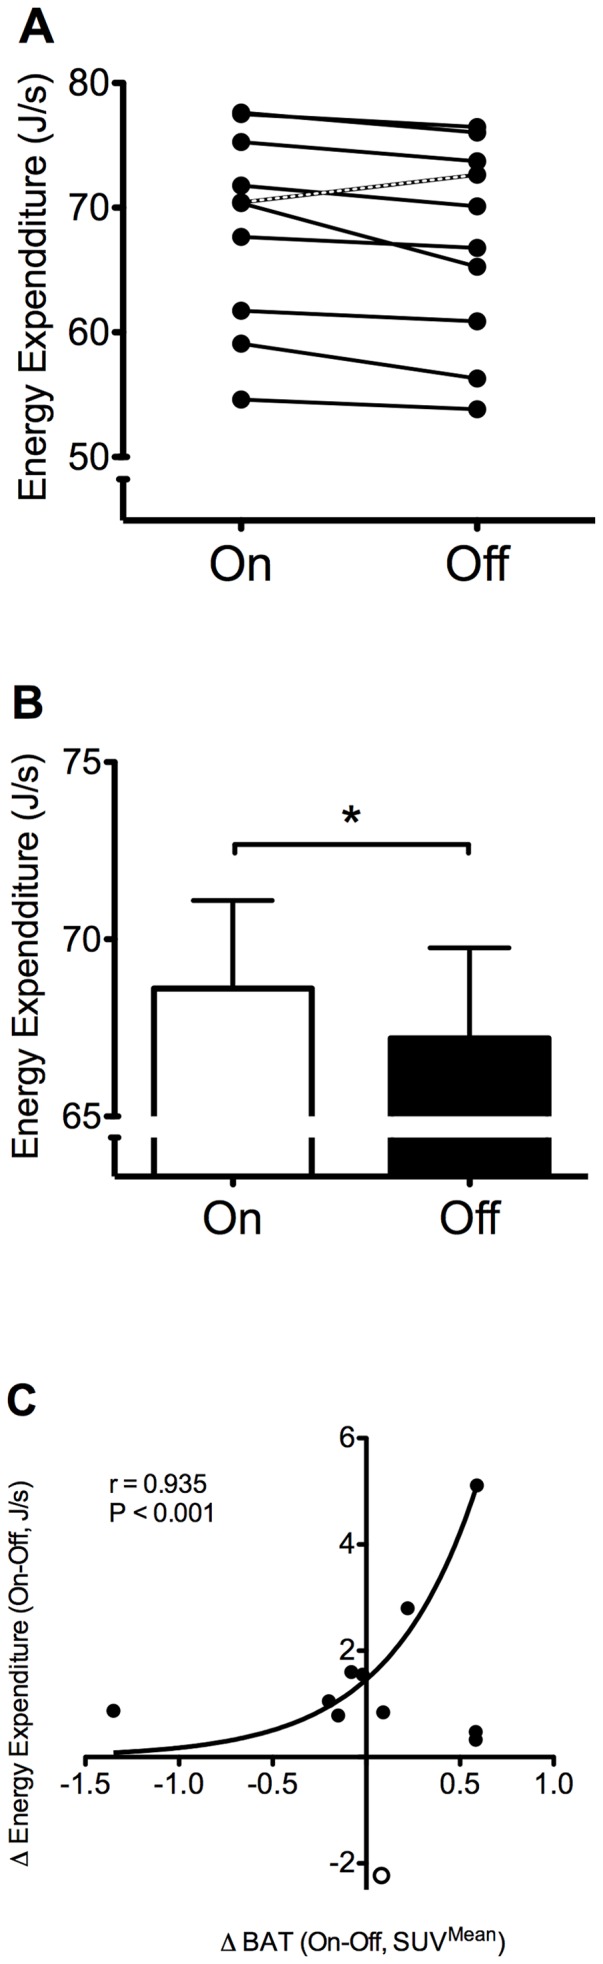
Basal metabolic rate (BMR) during active and inactive VNS in relation to BAT activity.
A. Individual responses upon VNS intervention. Notice all but one (marked line) subjects decreased energy expenditure upon deactivation of the VNS (subject that increased energy expenditure also described in Results section). B. Mean group BMR upon VNS intervention. C. The change in energy expenditure (Δ Energy Expenditure) upon VNS intervention (On/Off) correlated to the change in BAT activity. One subject (open dot) showed a high increase in energy expenditure upon VNS intervention. This subject was confirmed as an statistical outlier in the exponential growth equation shown and therefore excluded from the equation. Values shown are means + S.E.M. Significance shown for paired t-test in VNS intervention group consisting of 4 males and six females. * P<0.05